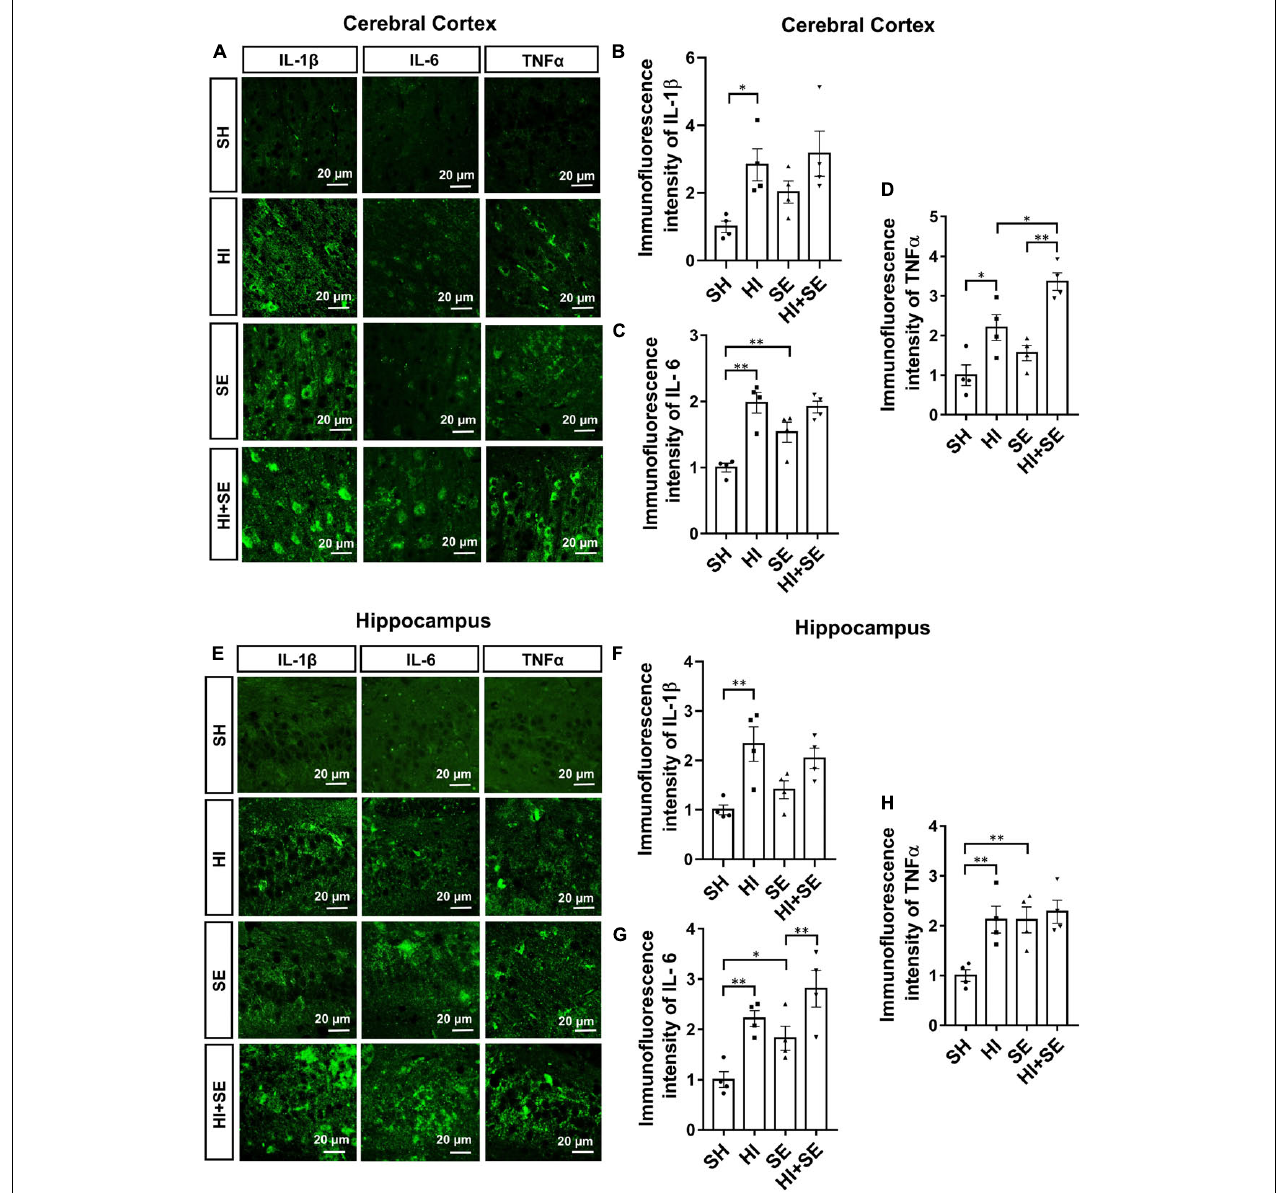
FIGURE 7 | Inflammatory response induced by HI injury and maternal SE. Representative images of immunofluorescence staining of inflammatory cytokines IL-1 β , IL-6, and TNF α in the cerebral cortex (A) and the hippocampus (E) . The immunofluorescence intensity of IL-1 β (B,F) , IL-6 (C,G) , and TNF α (D,H) in the cerebral cortex and hippocampus. Results are presented as mean ± SEM. ∗ P < 0.05, ∗∗ P < 0.01, n = 4, analyzed by two-way ANOVA followed by post hoc Turkey tests. SH, from sham exposed dams with sham surgery; HI, hypoxic-ischemic injury; SE, from smoke exposed dams with sham surgery; HI + SE, from smoke exposed dams with hypoxic-ischemic